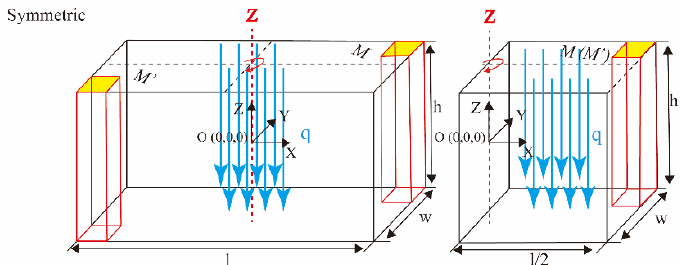
Figure 4. The relations of the antisymmetric thermal stimulus from rotational transformation.